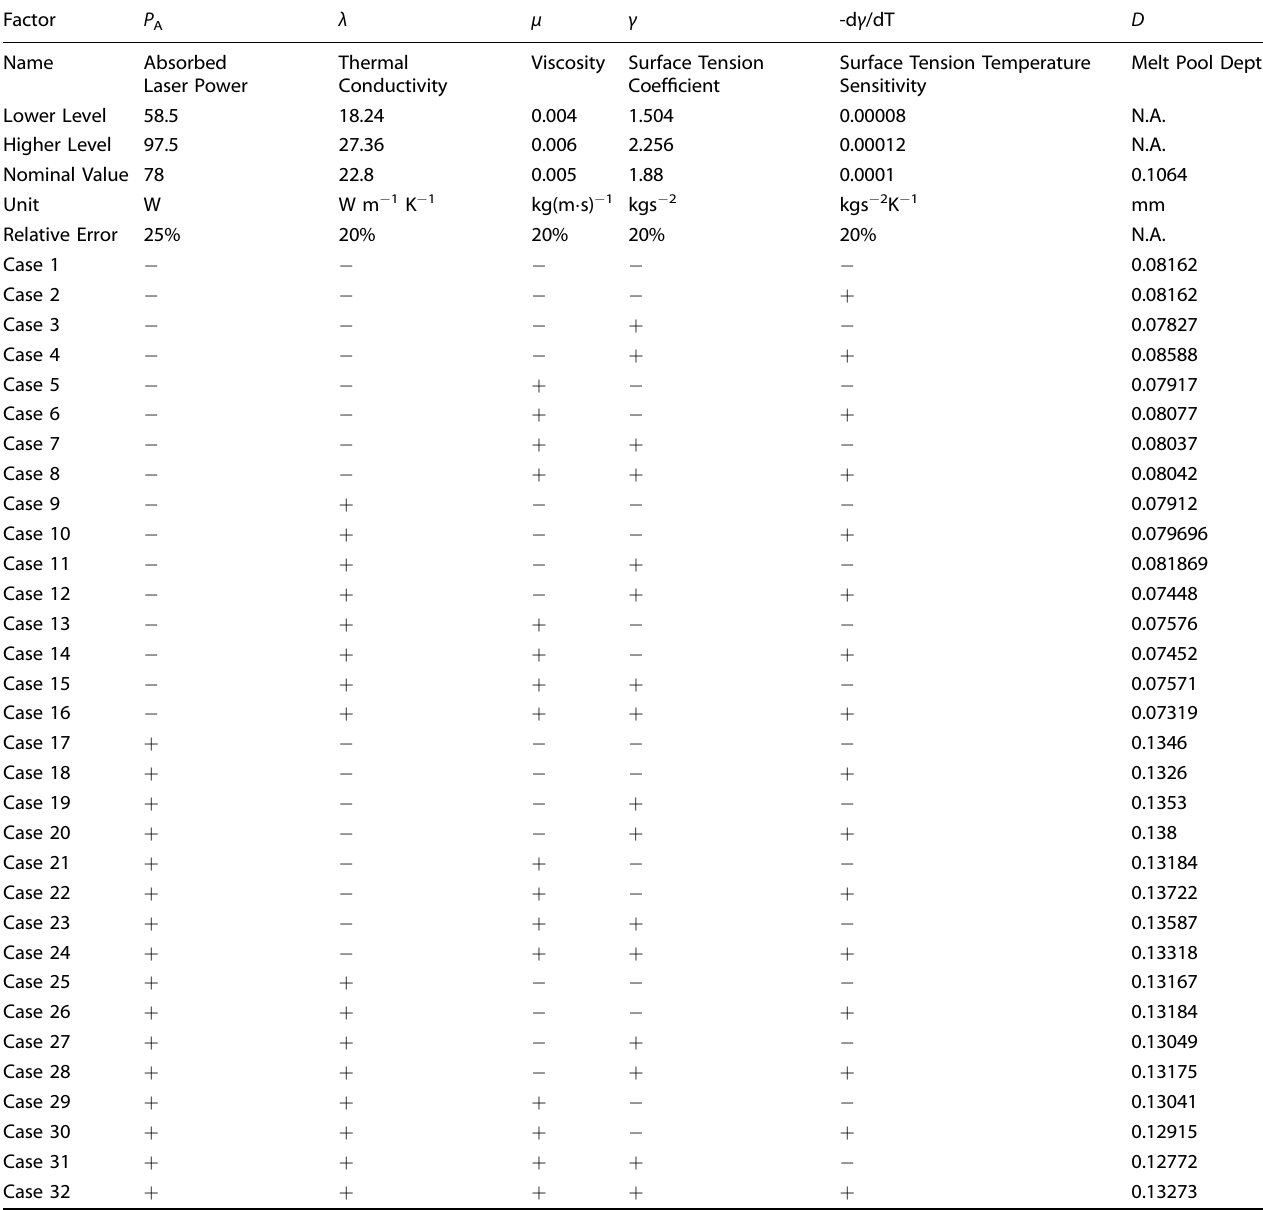
Table 8. Full factorial design of experiments for input factors ( P A , λ , μ , γ , − d γ /dT) with the corresponding output melt pool depth